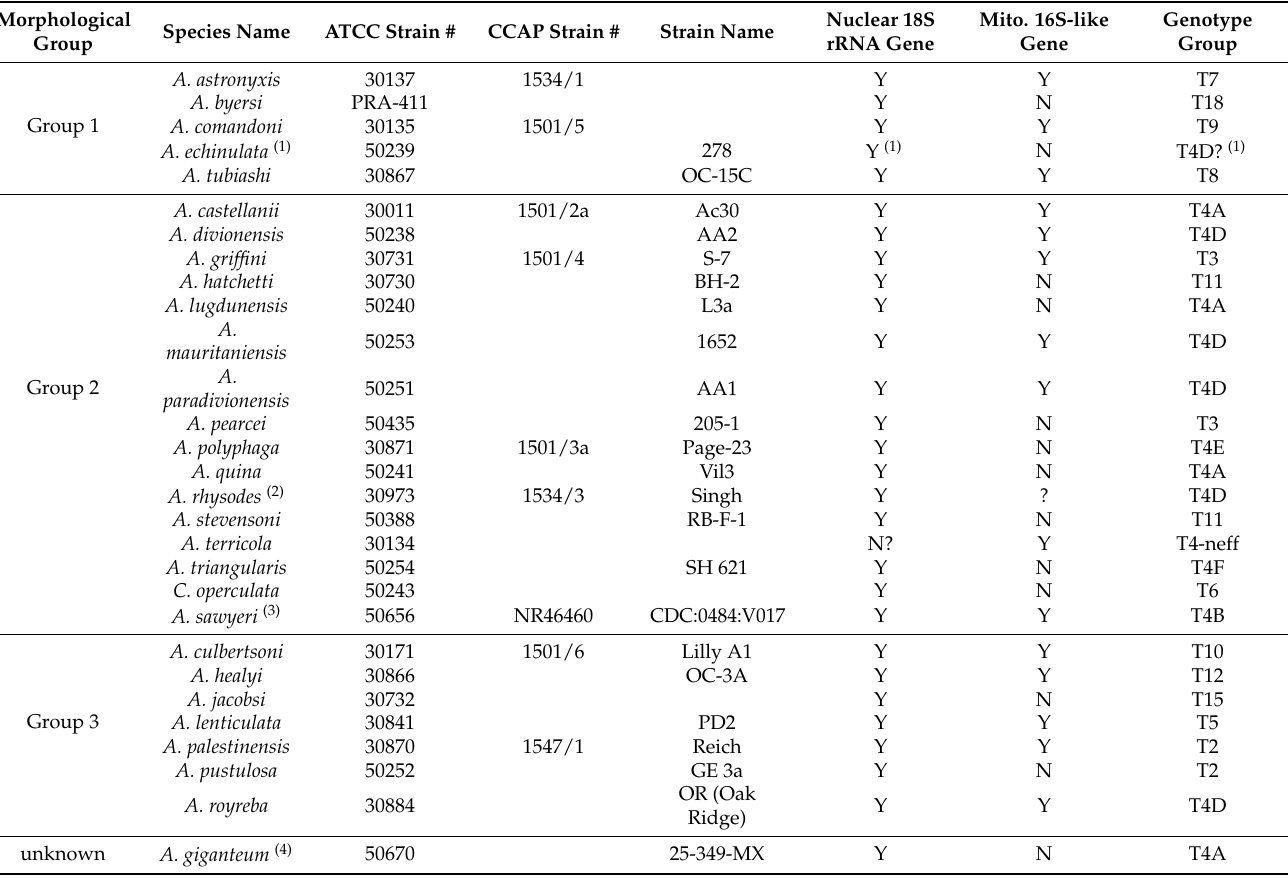
Table 4. Acanthamoeba species type isolates in culture